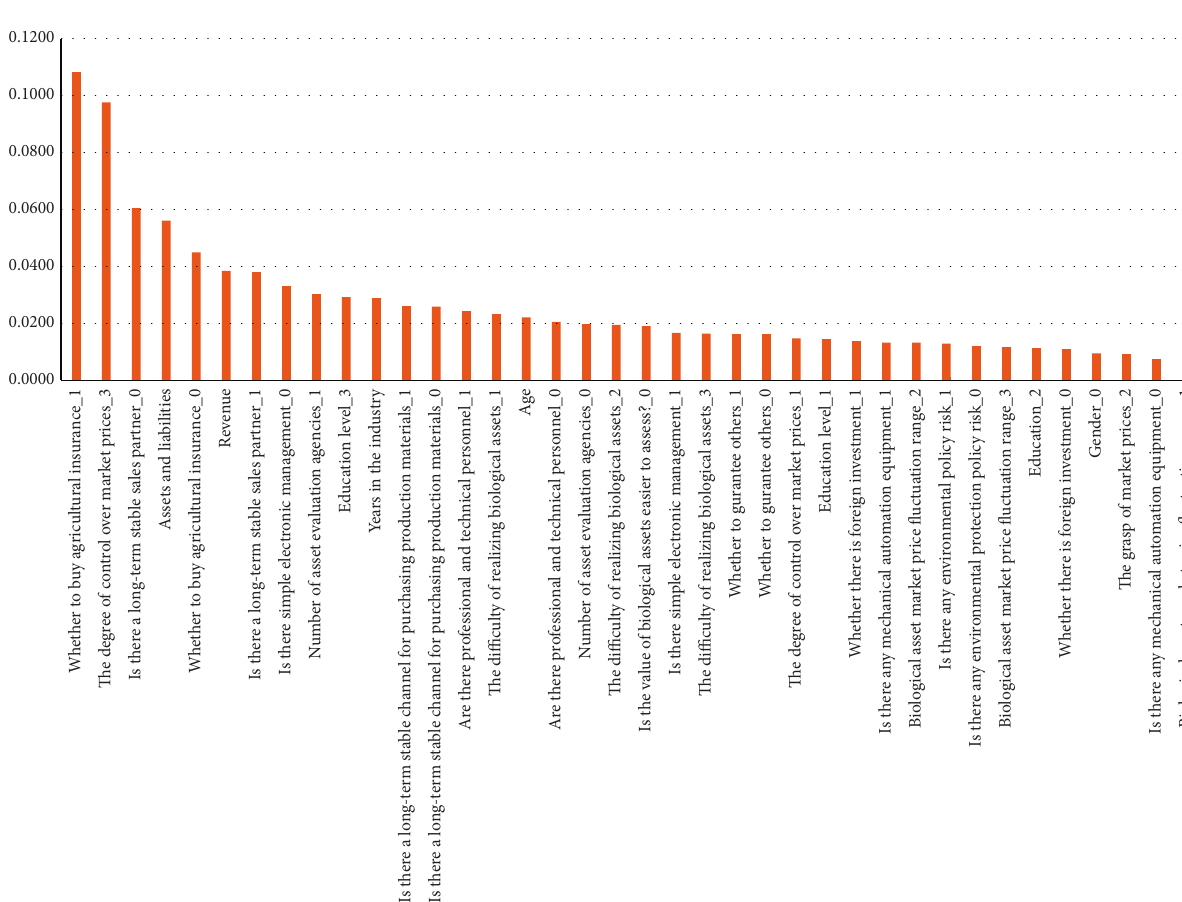
Figure 2: The importance of characteristics of biological asset mortgage risk